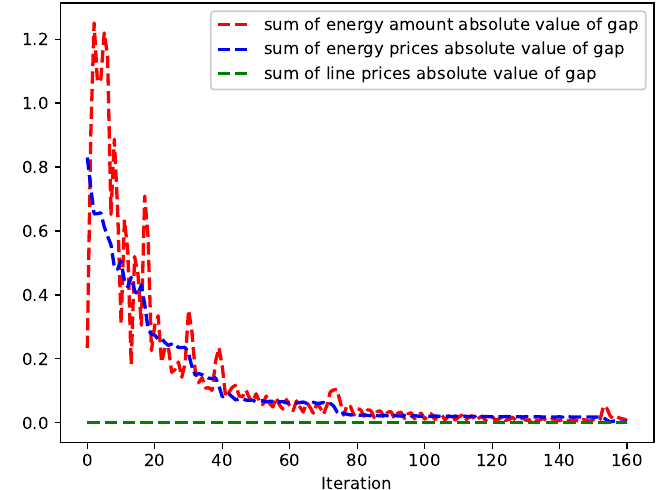
Table 2. Final traded quantities and prices of energy